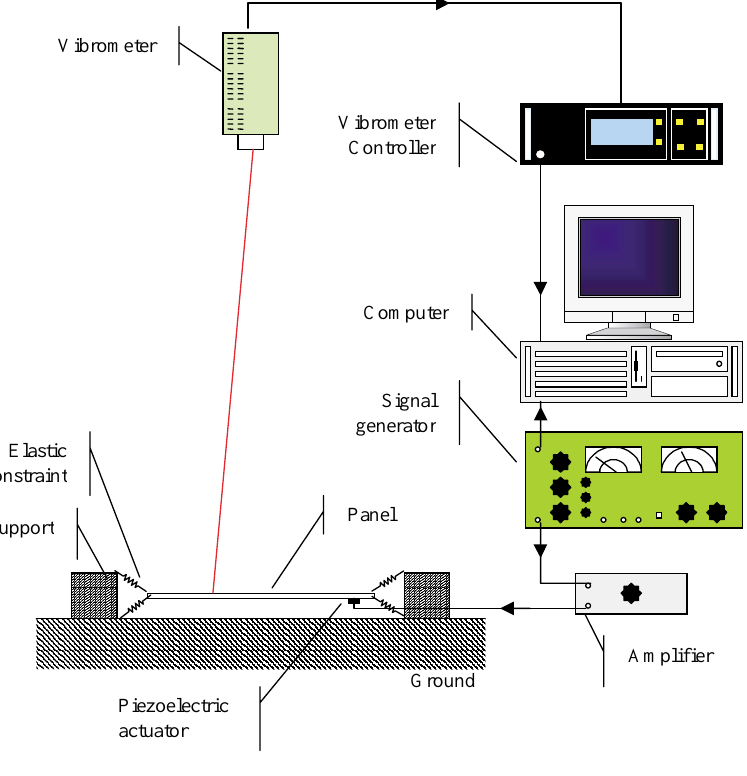
Fig. 1. Experimental